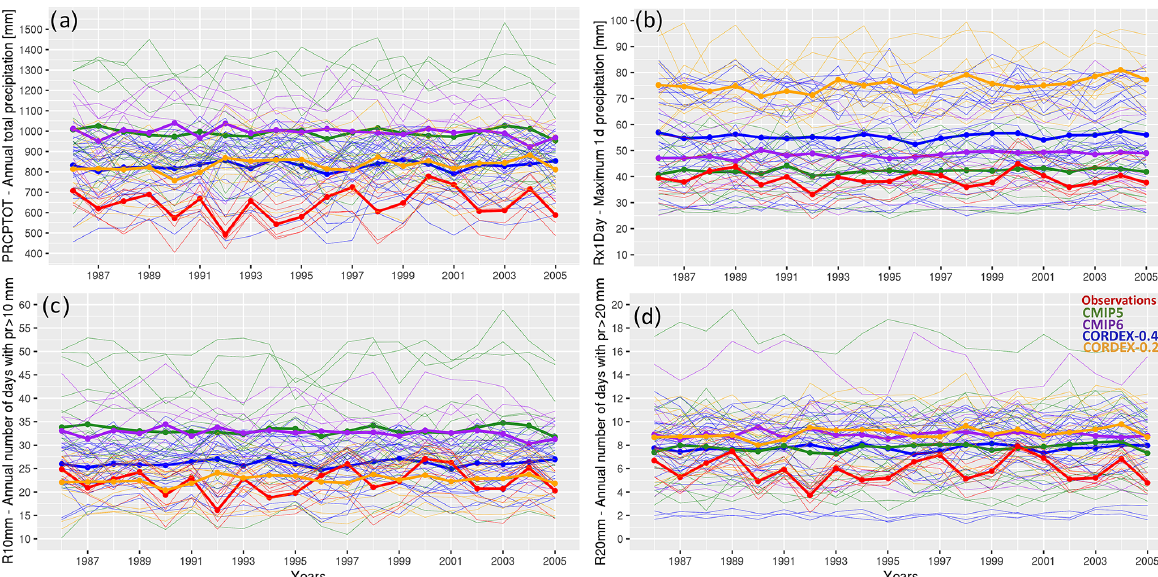
Figure 7. Time series of the ETCCDI indices over southern Africa (10 to 42 ◦ E and 10 to 35 ◦ S) for the observational ensemble in red (gauge-based, satellite and reanalysis), CMIP5 (Coupled Model Intercomparison Project Phase 5) ensemble in green, CMIP6 (Coupled Model Intercomparison Project Phase 6) ensemble in purple, CORDEX-0.44 ◦ ensemble mean of regional climate model simulations performed in the context of the Coordinated Regional Climate Downscaling Experiment – Africa domain with a spatial resolution equal to 0.44 ◦ × 0.44 ◦ in blue and CORDEX-0.22 ◦ in orange. Thin lines display single ensemble members, thick lines display ensemble means. The y axis on each panel depicts (a) PRCPTOT (total annual precipitation), (b) Rx1Day (annual maximum daily precipitation), (c) R10mm (annual number of days with daily precipitation > 10mm) and (d) R20mm (annual number of days with daily precipitation >